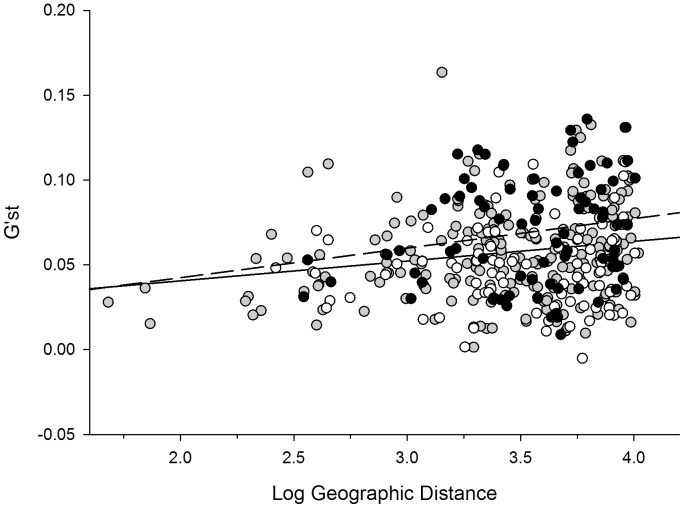
Isolation by distance graph.Correlation between Pairwise G’ST values and logarithmic transformed geographic distance for all populations (all circles, continuous line (RM = 0.17; β = 0.012; P = 0.001)), old populations (black circle, dashed line (RM = 0.19; β = 0.018; P = 0.043)) and recent populations (open circle, no regression line (RM = 0.069; β = 0.0044; P = 0.25)).